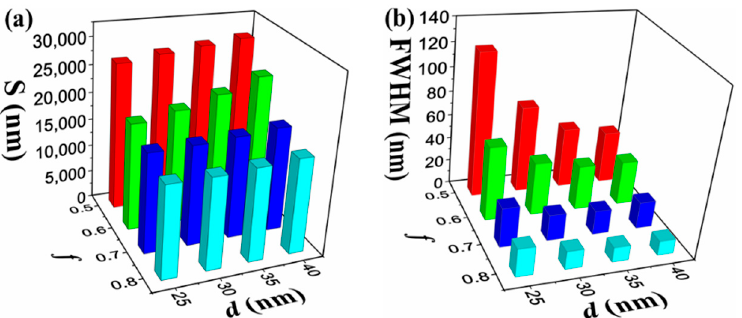
Figure 7. The dependence of S ( a ) and FWHM ( b ) on the f and d in the case of SRI changing from 1.330 to 1.335.